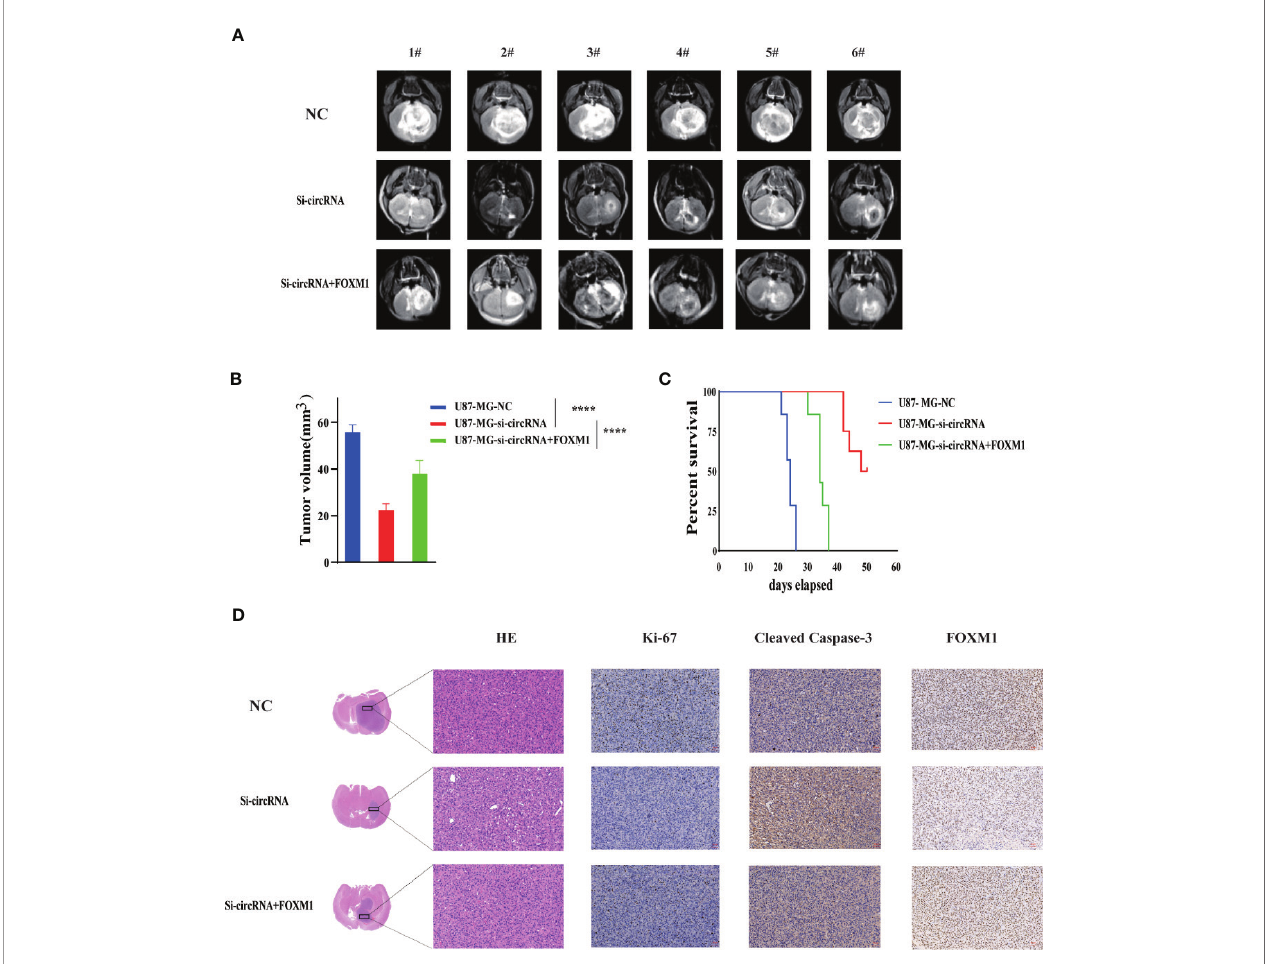
FIGURE 6 | CircPIK3C2A KD inhibits GBM progression and FOXM1 overexpression reverses the effects of circPIK3C2A in vivo. (A) Representative MR images of xenograft GBM tumors orthotopically inoculated with cells with NC, circPIK3C2A- KD and circPIK3C2A-KD+FOXM1 on 3 weeks post-implantation. (B) Tumor volumes were calculated for each group (n = 8 per group). (C) The comparative survival of mice bearing NC, circFOXO3-KD and circPIK3C2A-KD+FOXM1 tumors was determined. The time of death was recorded as days after U87-MG implantation. (D) Representative hematoxylin and eosin images of each group are shown (magni fi cation: 200×; scale bar =50 m m). Representative immunohistochemistry images of Ki-67, cleaved caspase-3, FOXM1 in tumors collected from each group (magni fi cation: 40×; scale bar = 50 m m). Signi fi cant results are presented as ****P <